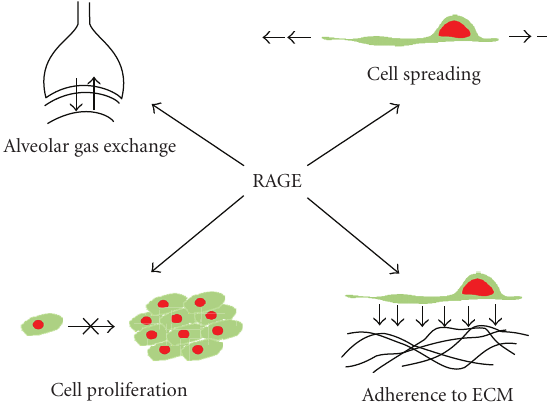
Figure 3: RAGE is central to many fundamental biological processes in the lung. Expression of RAGE has been shown to promote spreading of adherent cells on collagen IV and in doing so may ensure e ff ective gas exchange. RAGE-expressing epithelial cells exhibit diminished proliferative capacity compared to non- expressing cells. Cells overexpressing RAGE adhere much faster to collagen IV, and to a greater extent when compared to mock transfected cells suggesting an important role in cell-extracellular matrix